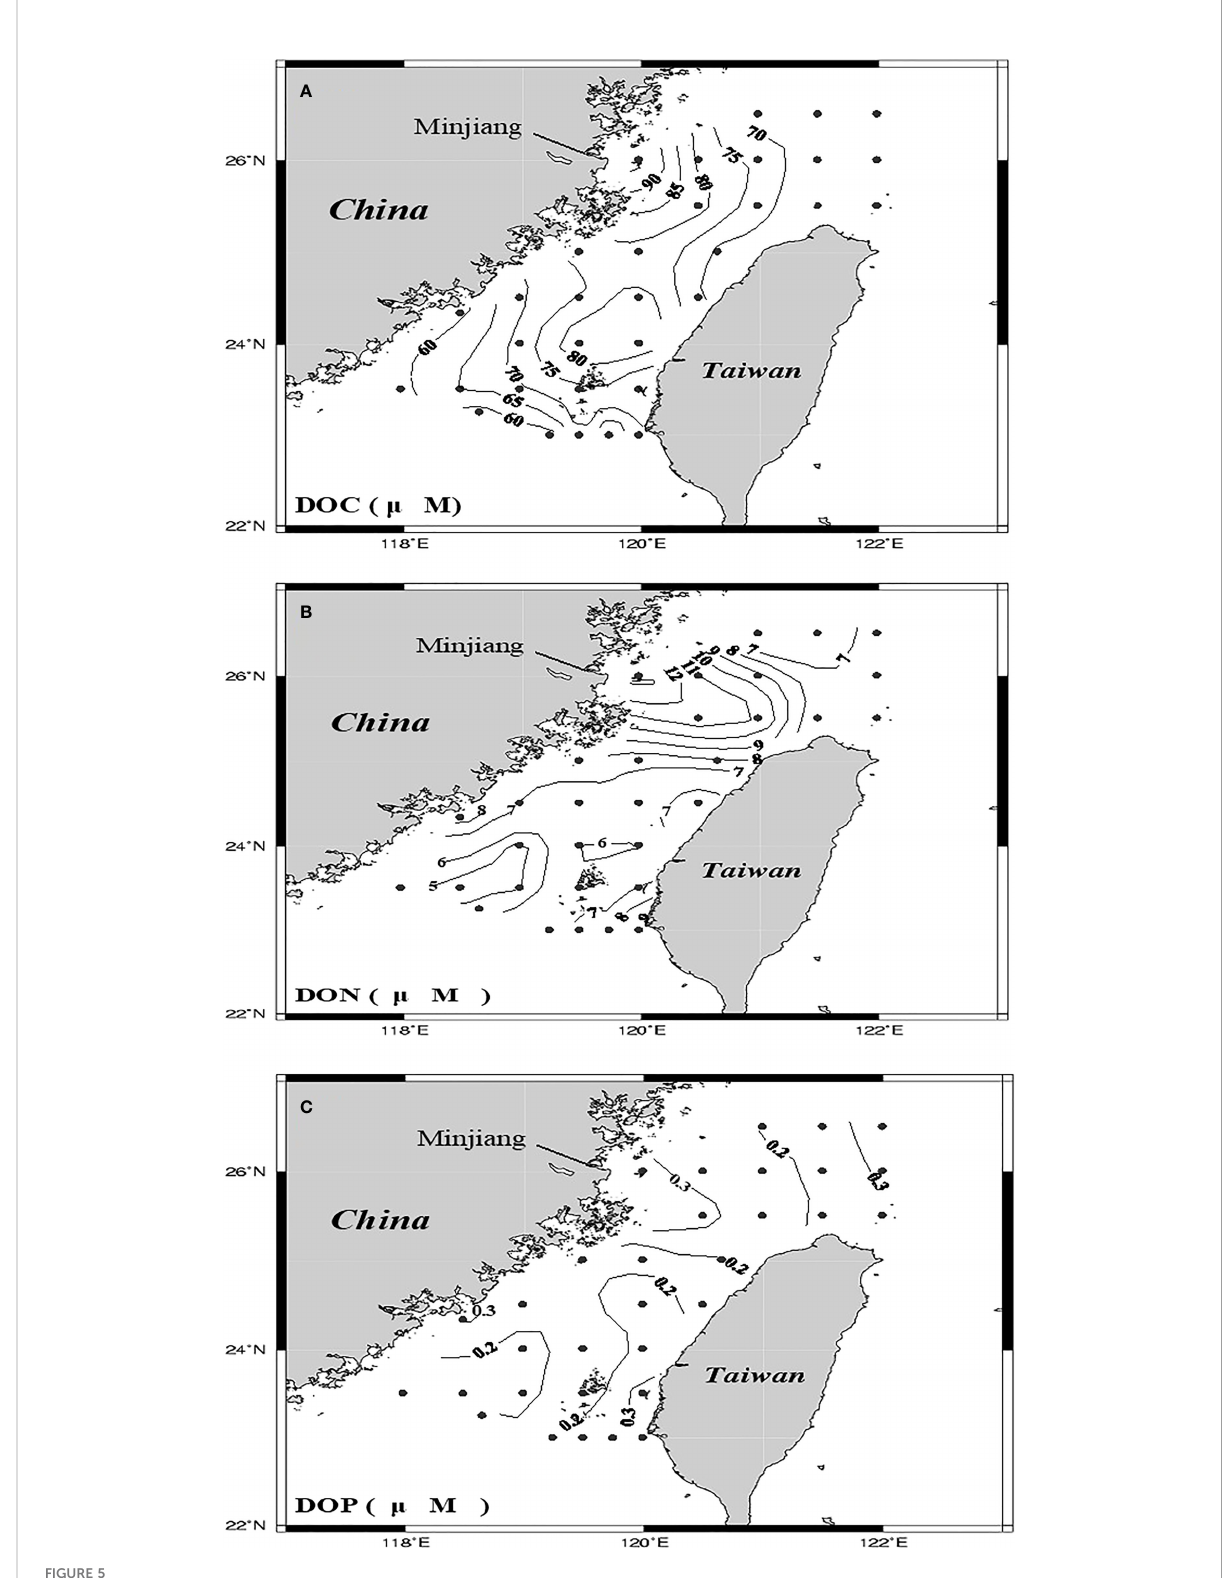
FIGURE 5 Spatial distributions of DOC (A) , DON (B) , and DOP (C) concentrations in surface waters of the TS in early summer